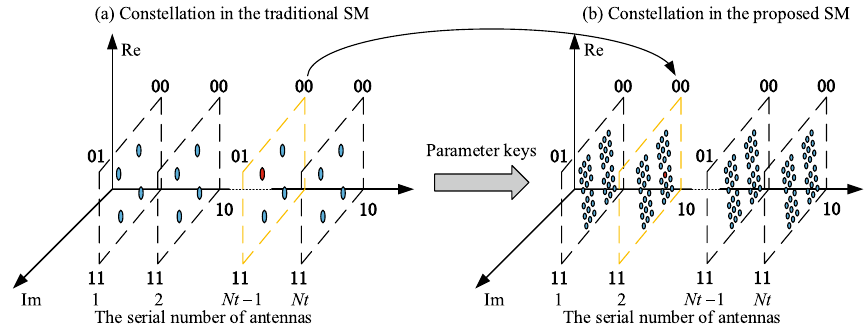
Fig. 6 Constellation diagram comparison between the proposed scheme and the traditional SM